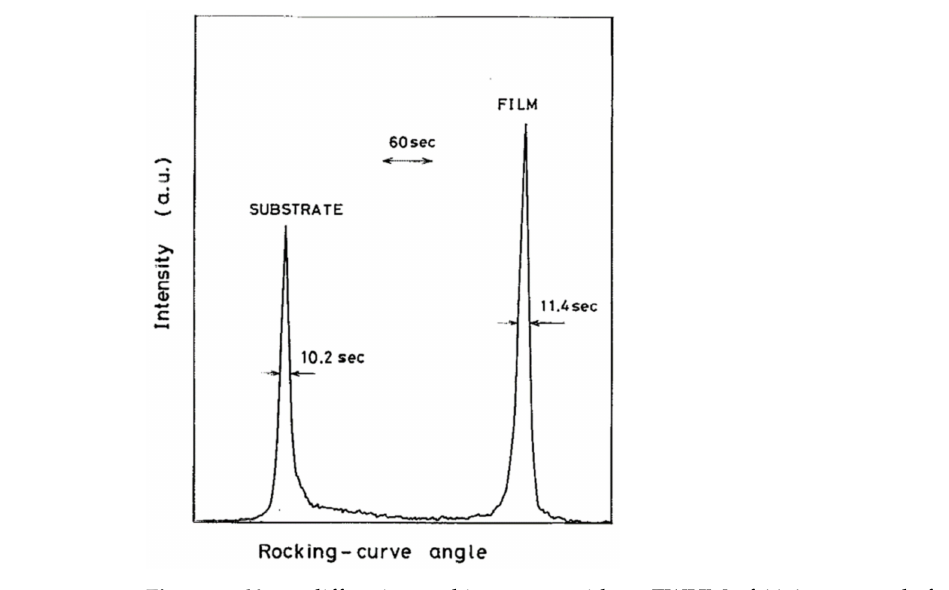
Figure 3. X-ray diffraction rocking curve with an FWHM of 11.4 arcseconds from a LN thin film grown in 1992 via liquid phase epitaxy (LPE) by Yamada et al. [23], juxtaposed with the MgO-doped LN